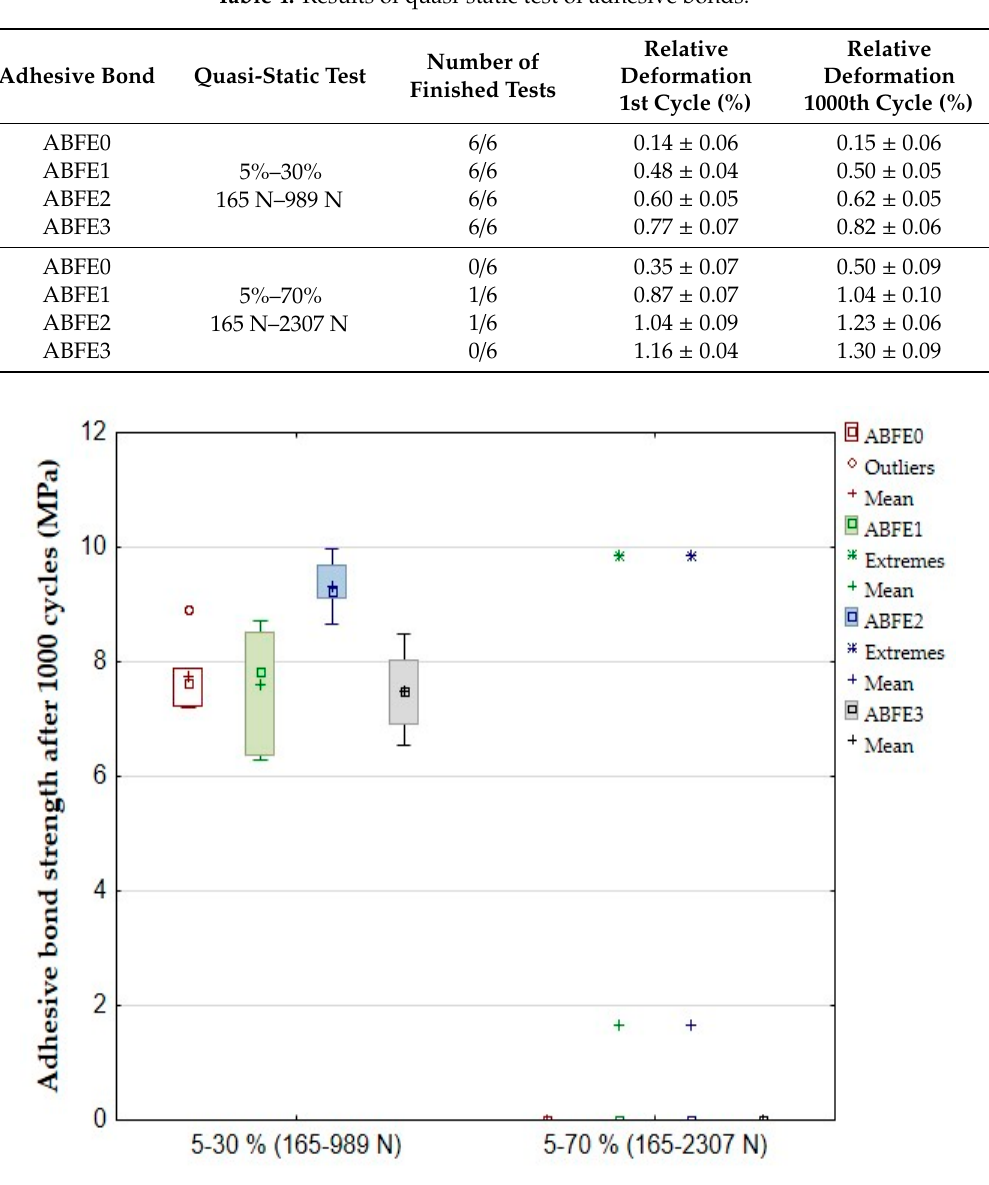
Figure 8. Quasi-static test of adhesive bonds—shear tensile strength after 1000 cycles.